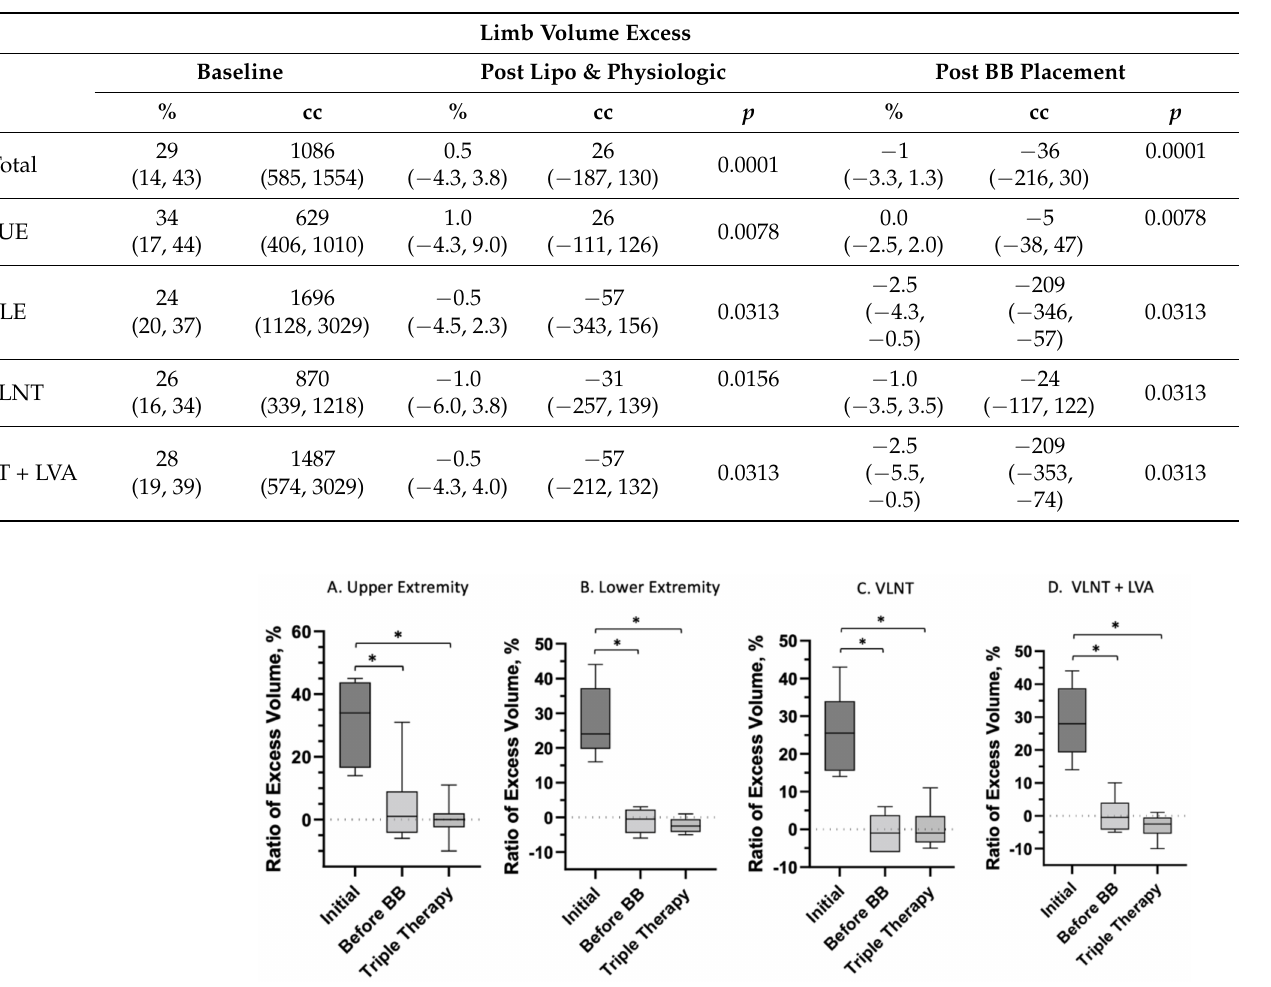
Figure 6. Subgroup analysis of patient median volume excess ratio at baseline, after liposuction and physiologic surgery, and after BB placement. Data are presented as median values and IQR. Statistically significant values ( p < 0.05) are indicated by an asterisk